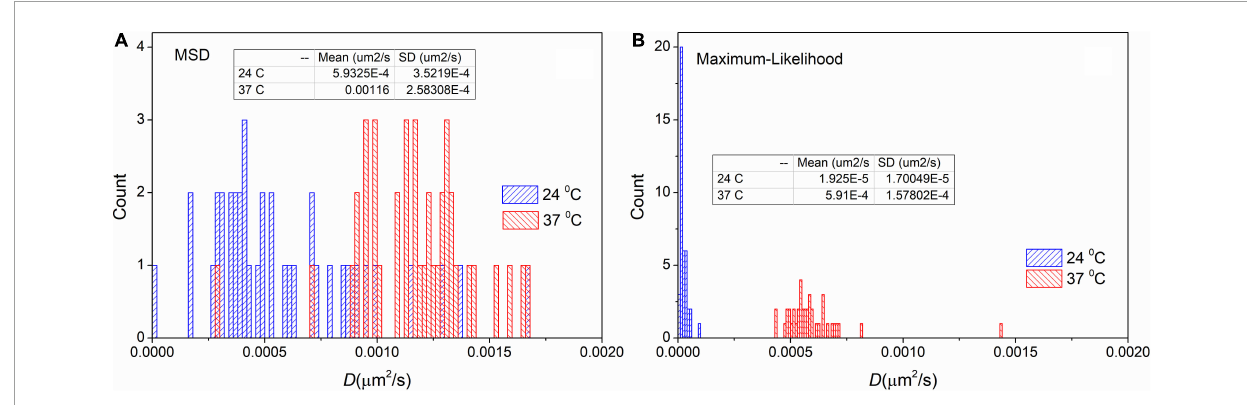
FIGURE4 Distribution of diffusion coefficients derived from trajectories recorded on immobile particles. The measurement was carried out on different temperatures and the extracted trajectories were analyzed by the mean square displacement (MSD) (A) and the maximum likelihood-based estimation (MLE) (B) method. The inserted table shows the mean and SD values for each group, respectively.